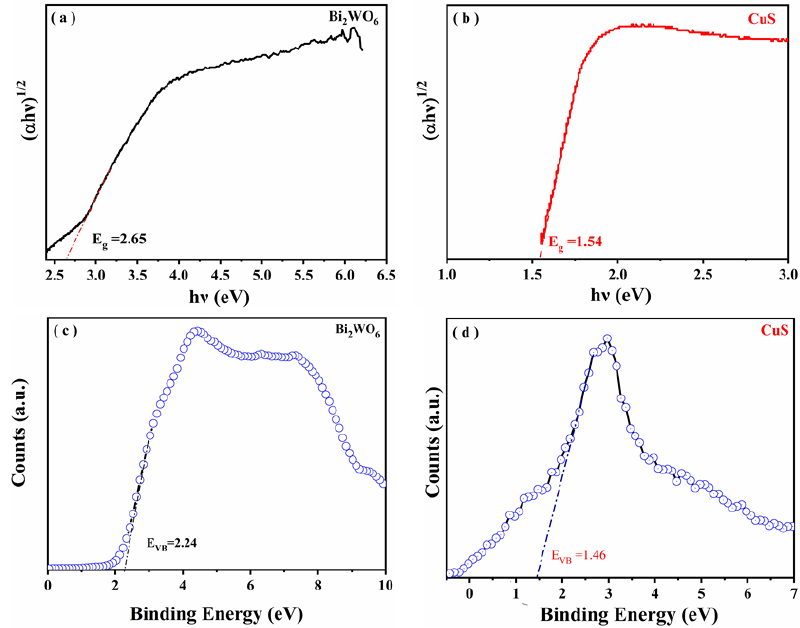
Figure 12. Tauc plots of (αhν) 1/2 vs. hν for the samples Bi 2 WO 6 ( a ) and CuS ( b ) and XPS valence band spectra of Bi 2 WO 6 ( c ) and CuS ( d ).